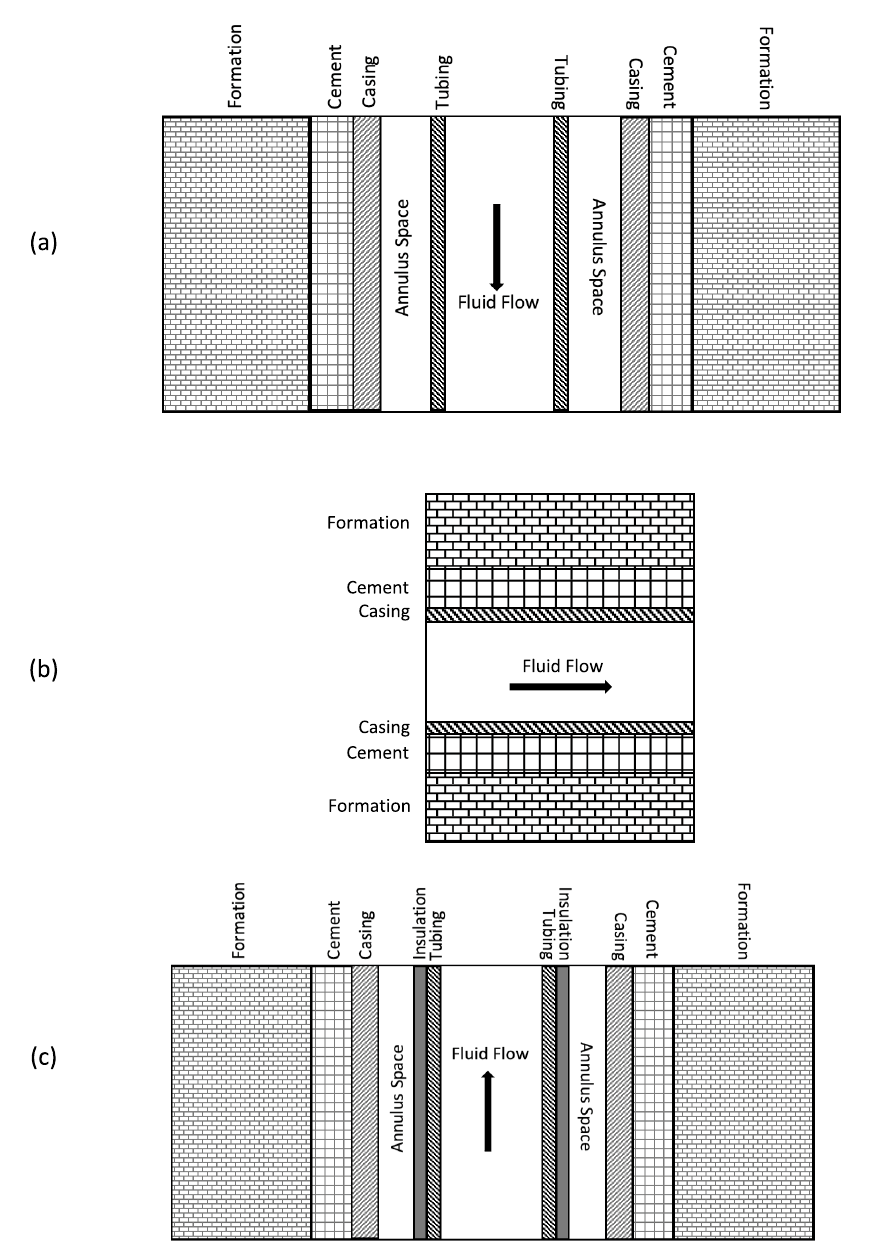
Fig. 3 Well completion design: a descending interval, b horizontal interval, and c ascending